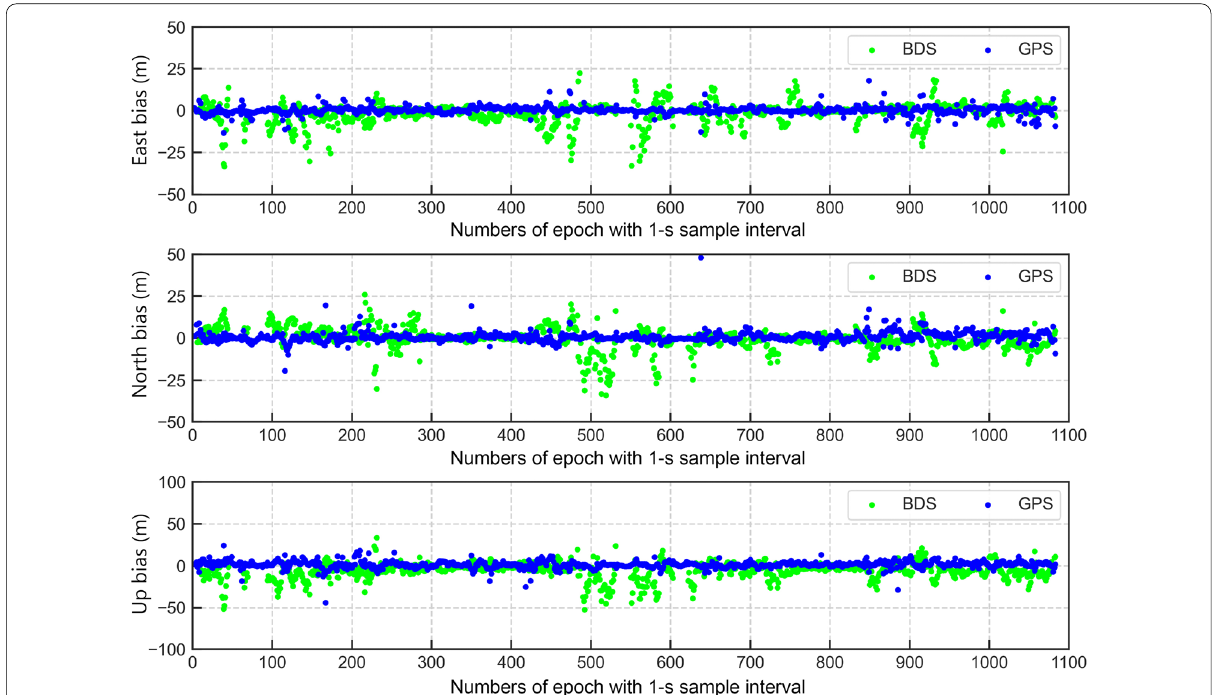
Fig. 20 Kinematic smartphone positioning biases of BDS and GPS with respect to the BDS/GPS